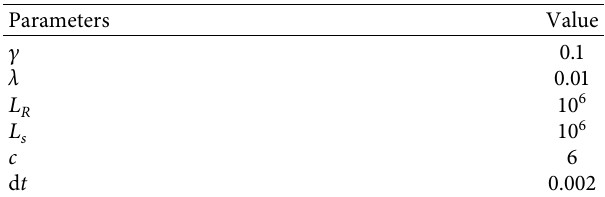
Table 3: Parameters for obtaining K and simulation for τ � 1s and constant disturbance.